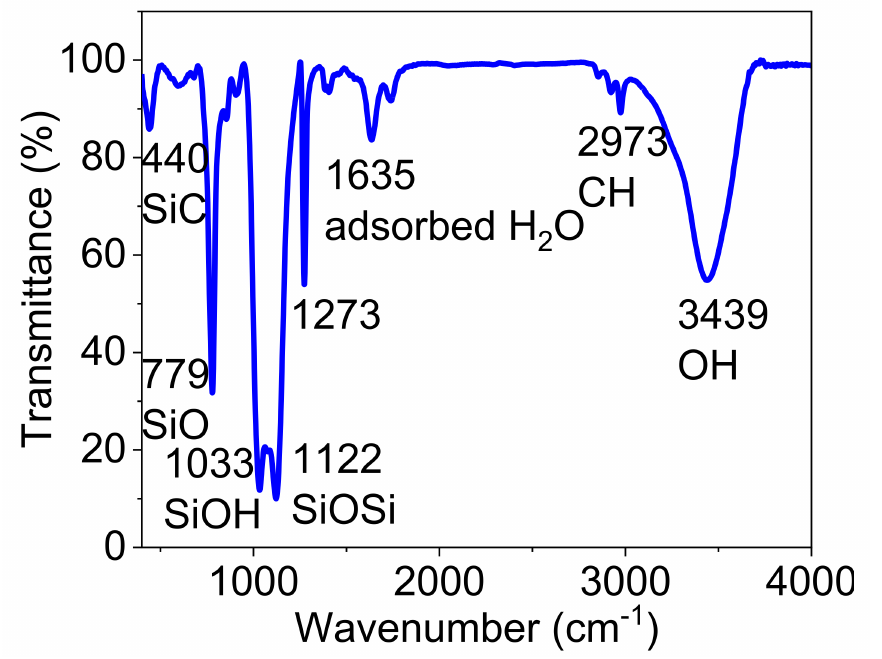
Figure 2. FT-IR spectrum of Pd@C–PS. The Raman spectrum of Pd@C–PS also revealed peaks attributing to Si and SiC (Figure 3). The exact value of the Raman shift for Si in the composite is size-dependent